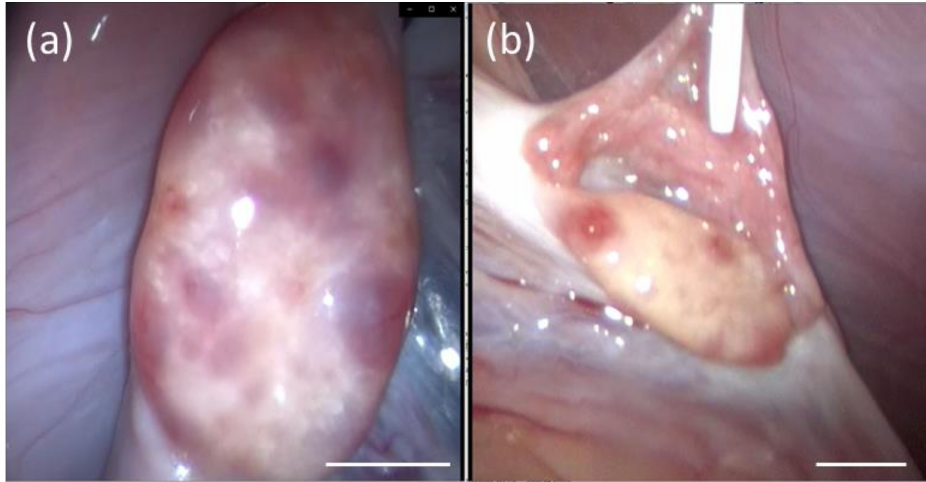
Figure 2. Representative pictures from laparoscopy. Ovary from Donor 3 ( a ) with preovulatory follicles (darker areas) that were then aspirated to recover the oocytes. Ovary with fresh ovulation sites (bright red spots) and oviduct from Recipient 2 ( b ) during oviductal embryo transfer. Bar = 10 mm.